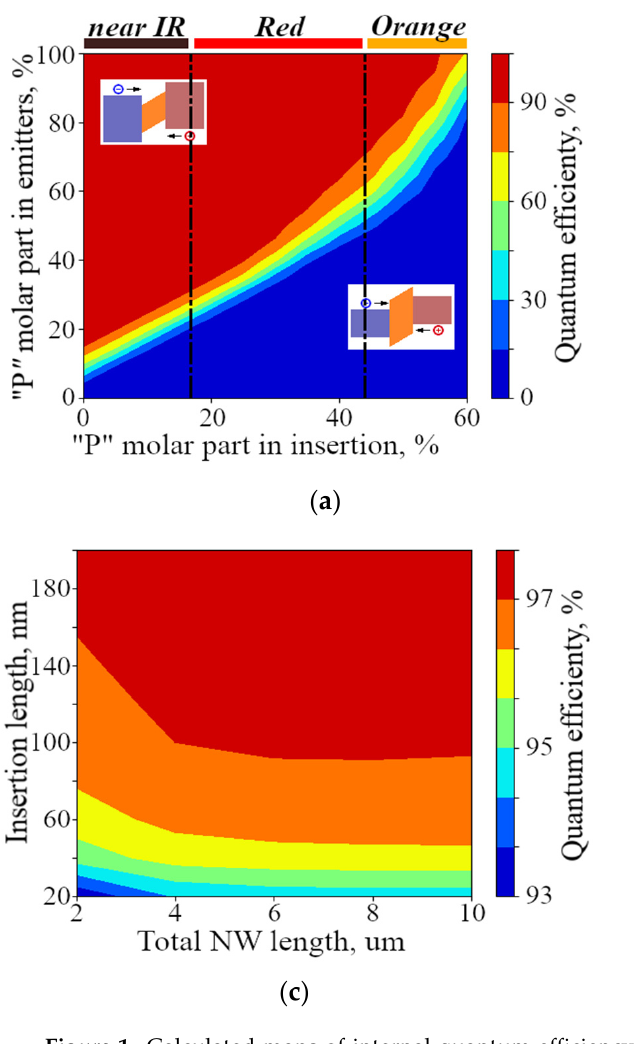
Figure 1. Calculated maps of internal quantum efficiency (IQE) and power efficiency (PE) dependent on P content in emitters and active region insertion ( a , b ), and nanowire (NW) ( c , d ) length display IQE and PE maps, respectively, dependent on the total NW length and the insertion length. For the lengths of NWs less than 5 µm the dependency on both lengths is negligible for the insertion length lying in the range of (80–200) nm.